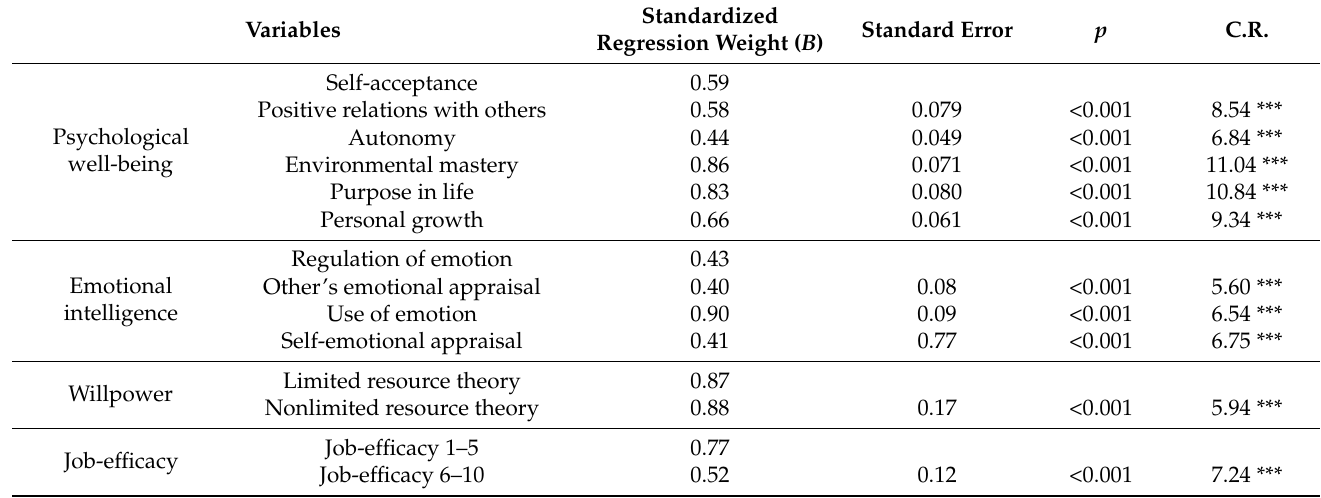
Table 5. Confirmatory factor analysis of the measurement model.